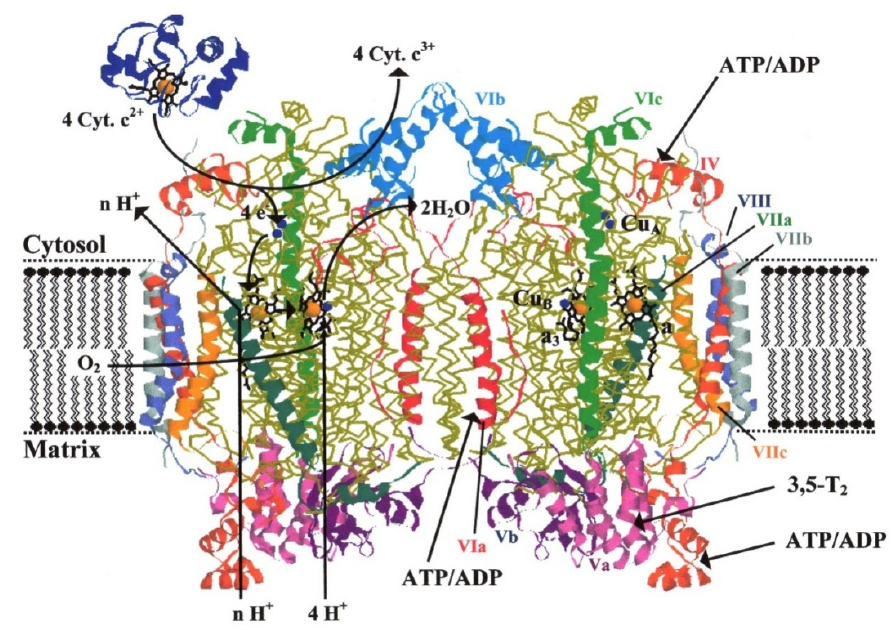
Figure 6. Crystal structure of dimeric bovine heart CytOx [26]. Coordinates (PDB entry 1occ)) were processed with the Swiss PDB Viewer/Pov Rayprogram (E. Schwan, Ray Tracing for the Macintosh CD, Waite Group Press, Corte Madera (CA, USA), 1994). The three mitochondrially coded subunits in each monomer are represented as peptide backbone traces (yellow) with their redox centers highlighted, while the helices of nuclear-coded subunits are numbered and labeled as color-coded ribbons in the right-hand monomer. The monomer on the left depicts schematically the pathway of electrons entering from the donor, cytochrome c (top left drawn in blue; shown in a somewhat arbitrary position), oxygen binding to the binuclear center, and pathways and stoichiometry for matrix proton uptake and release on the cytoplasmically oriented side of the mitochondrial inner membrane (with the positioning of the phospholipid bilayer solely for illustration). In the monomer on the right, the location of the potential binding sites for ATP (or ADP) and 3,5-diiodothyronine, are indicated [34] and suggested proton channels are shown at the monomer on the left side [36].